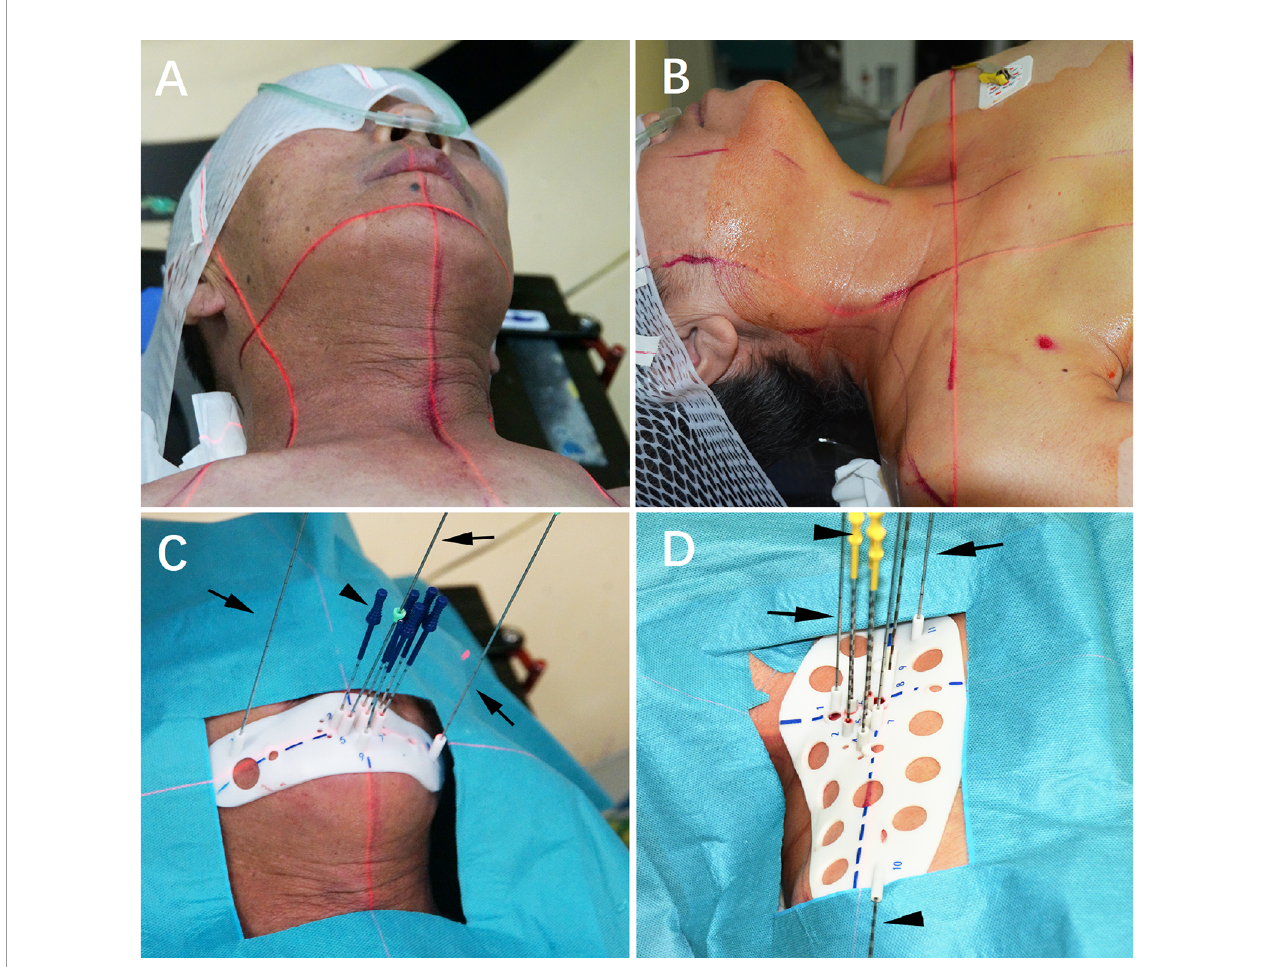
FIGURE 3 | I 125 radioactive seed implantation. (A, B) Patients were fi xed; (C, D) Individualized 3D-printing template (3D-PT) was